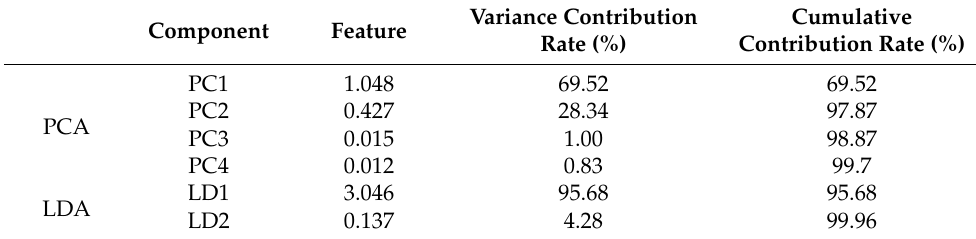
Table 4. The features and component contribution